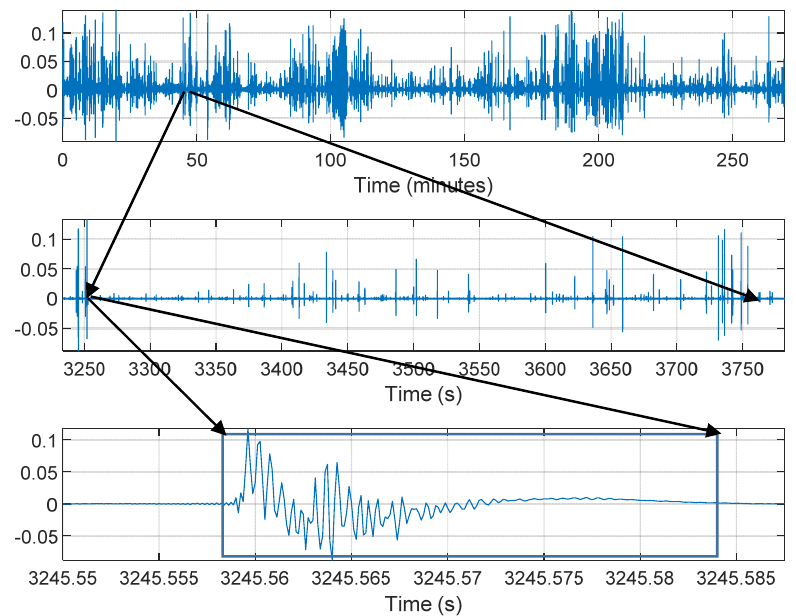
Figure 5. Looking at a recording of an infested mulberry with X. chinensis at different time-scales. Top: a 4 h 30 min continuous recording. Middle: a pulse train between 53 min 50 s–63 min 20 s. Bottom: a single burst corresponding to a crack of fiber.